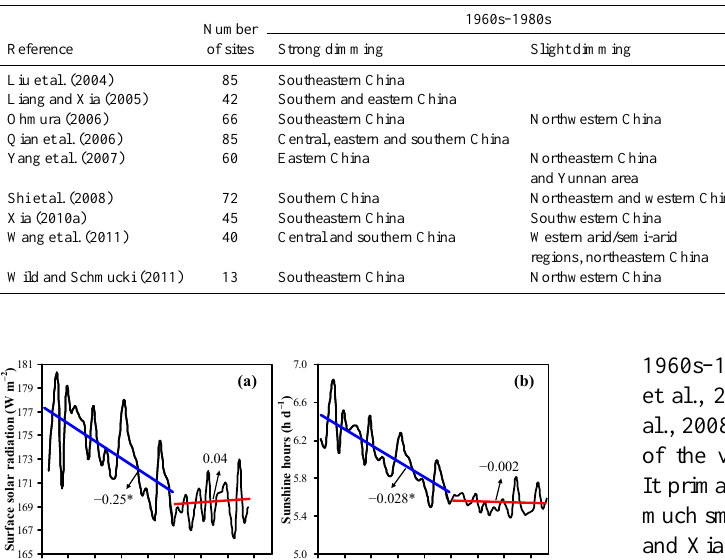
Table 2. Regional characteristics of surface solar radiation trends in China for the 1960s–1980s (dimming phase) and 1990s–2000s (bright- ening phase).